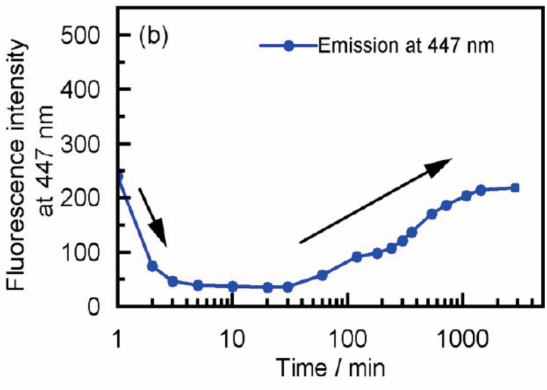
Figure 22. Formation of type I gels shown by fluorescence/time profiles. Reproduced from reference 72 by permission from